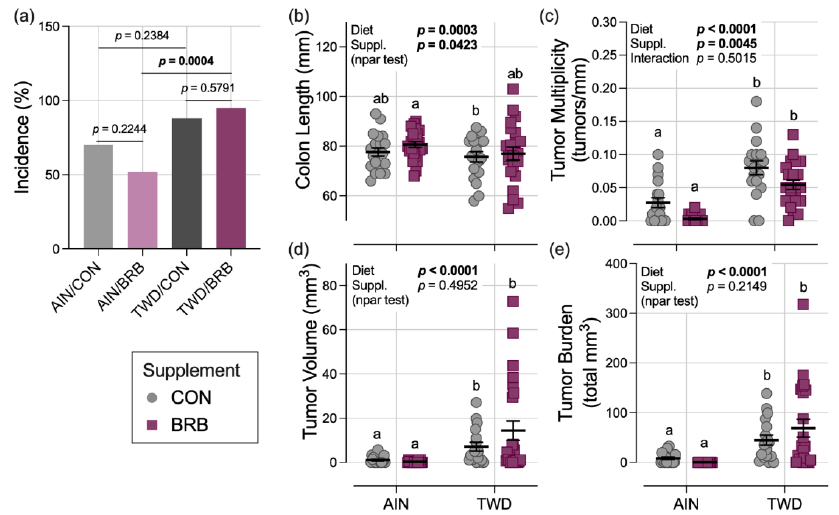
Figure 5. Effect of BRB supplementation on colon length and colon tumorigenesis in mice fed AIN or TWD basal diets (experiment B). ( a ) Incidence of colon tumors shown as the percent of mice with tumors at the terminal time point. P-values from pairwise Fisher exact tests (selected a priori ) are shown. ( b ) Colon length. ( c ) Colon tumor multiplicity (number of tumors per mm colon length). ( d ) Average tumor volume. ( e ) Tumor burden (total volume). For ( b – e ), data are shown as individual values with mean ± SE. Inset tables show the statistical model main effects for diet, treatment and their interaction or “npar test” if a non-parametric test was required, and different letters indicate that experimental groups are significantly different ( p < 0.05), as determined by statistical methods outlined in the Materials and Methods section.